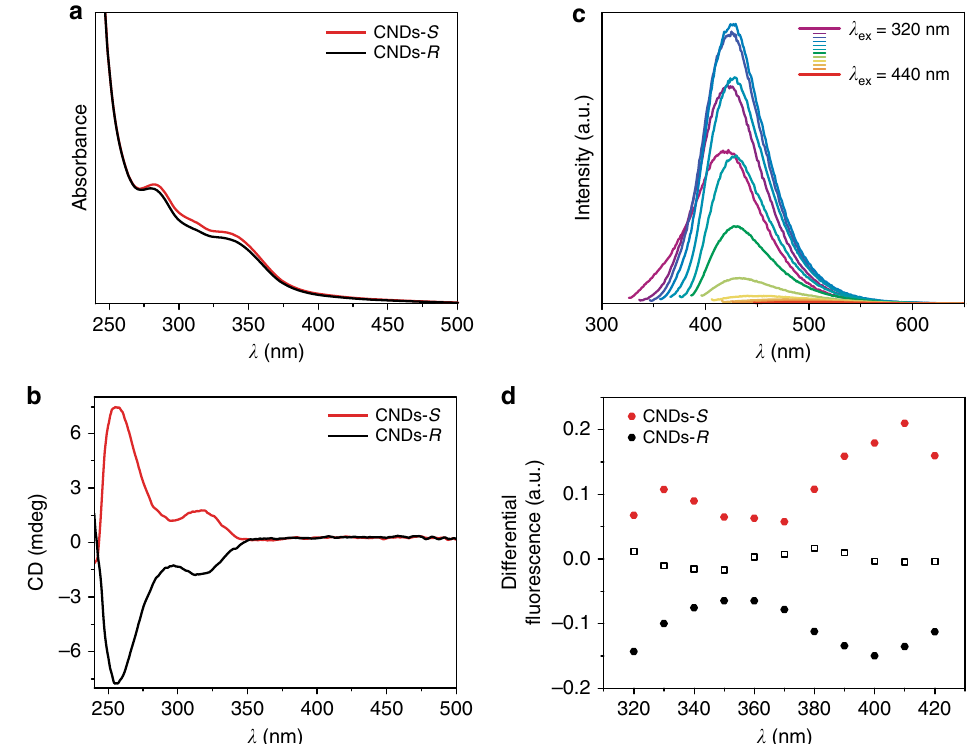
Fig. 3 Photophysical and (chiro)optical characterization of CNDs- S and CNDs- R . Experiments performed in water at 298 K. a UV – Vis spectra of CNDs- S (red line) and CNDs- R (black line); b ECD spectra of CNDs- S (red line) and CNDs- R (black line); c FL emission spectra (at different excitation wavelengths) of CNDs- R (same emission pro fi les and intensities were observed for CNDs- S ); d FDCD for CNDs- S (red circles), CNDs- R (black circles) and fl uorescein (empty squares), measured using the experimental conditions reported in the Supplementary Methods, at the angle θ =